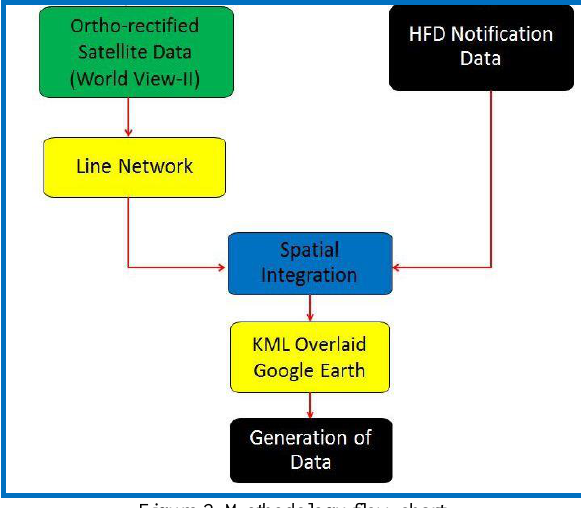
Figure 2. Methodology flow chart